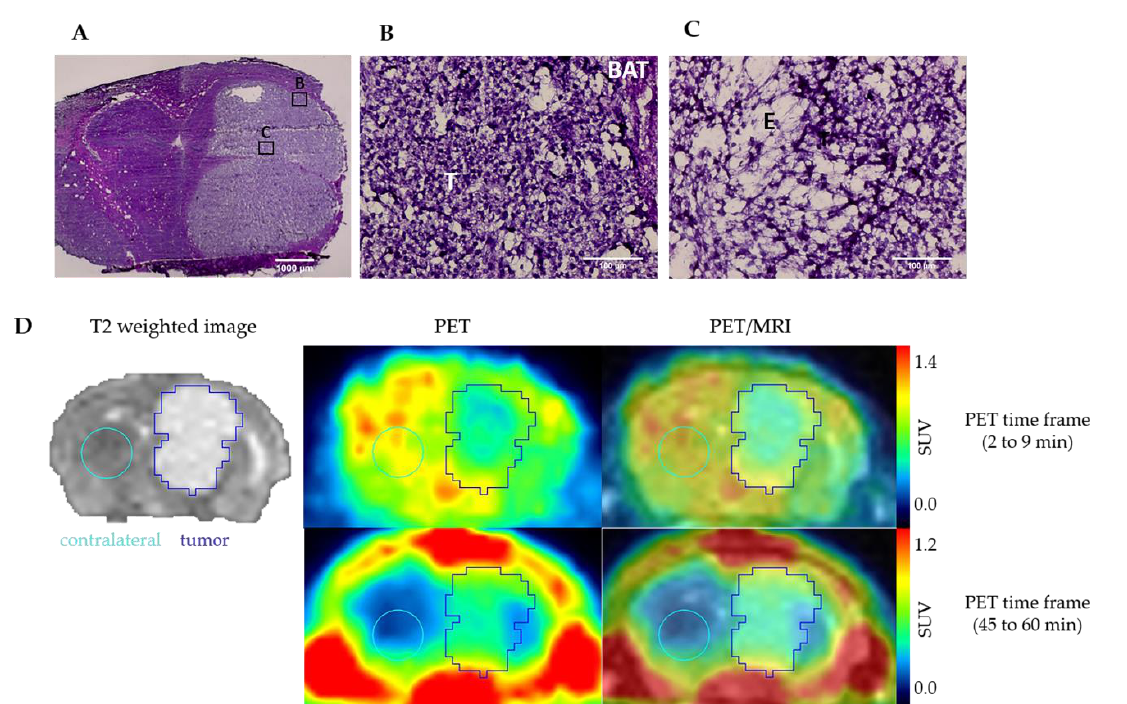
Figure 5. Hematoxylin-eosin staining of U87-MG tumour: ( A ) tumour bulk in the right striatum of a mouse brain (×2, scale bar: 1000 µm); ( B ) tumour periphery presents area of high density of cell nuclei; ( C ) tumour centre presents area of lower cell density accompanied by oedema. (×40, BAT: brain adjacent to tumour; T: tumour, E: oedema. Scale bar: 100 µm. ( D ) Representatives coronal PET / MR images of U87-MG tumour-bearing mouse after i.v. administration of (S)-( − )-[ 18 F]fluspidine. The upper panel exhibits the distribution of ( S )-( − )-[ 18 F]fluspidine at early times p.i. (averaged time frames from 2 to 9 min), and the lower panel exhibits the distribution of ( S )-( − )-[ 18 F]fluspidine at later times (averaged time frames from 45 to 60 min).